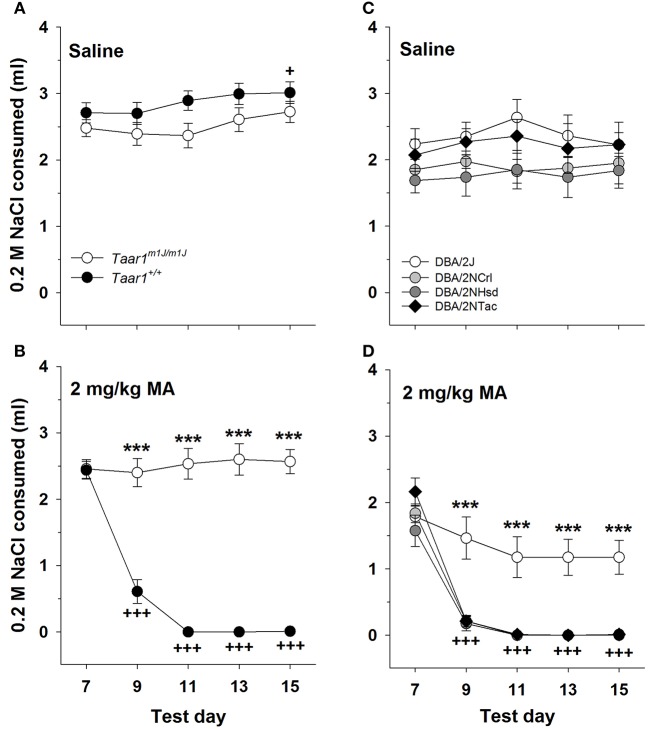
The Taar1m1J/m1J genotype is associated with insensitivity to MA-induced CTA. Mean ± SEM NaCl consumed initially (Test day 7) and after pairing with saline (A) or 2 mg/kg MA (B) injections (Test days 9–15) in homozygous Taar1m1J
and Taar1+ BXD RI mice. For panels (A,B)
***p < 0.001 for the comparison of the two genotypes on the indicated test day; +p < 0.05 for overall NaCl intake on test day 15, compared to test day 9; +++p < 0.001 for NaCl intake in Taar1+/+ mice on each indicated day, compared to test day 7. Mean ± SEM NaCl consumed initially (Test day 7) and after pairing with saline (C) or 2 mg/kg MA (D) injections (Test days 9–15) in DBA/2 mice. For panels (C,D)
***p < 0.001 for the comparison of DBA/2J mice to mice of the other 3 vendors on the indicated test day; +++p < 0.001 for NaCl intake in DBA/2NTac, DBA/2NCrl and DBA/2NHsd mice on each indicated day, compared to test day 7.